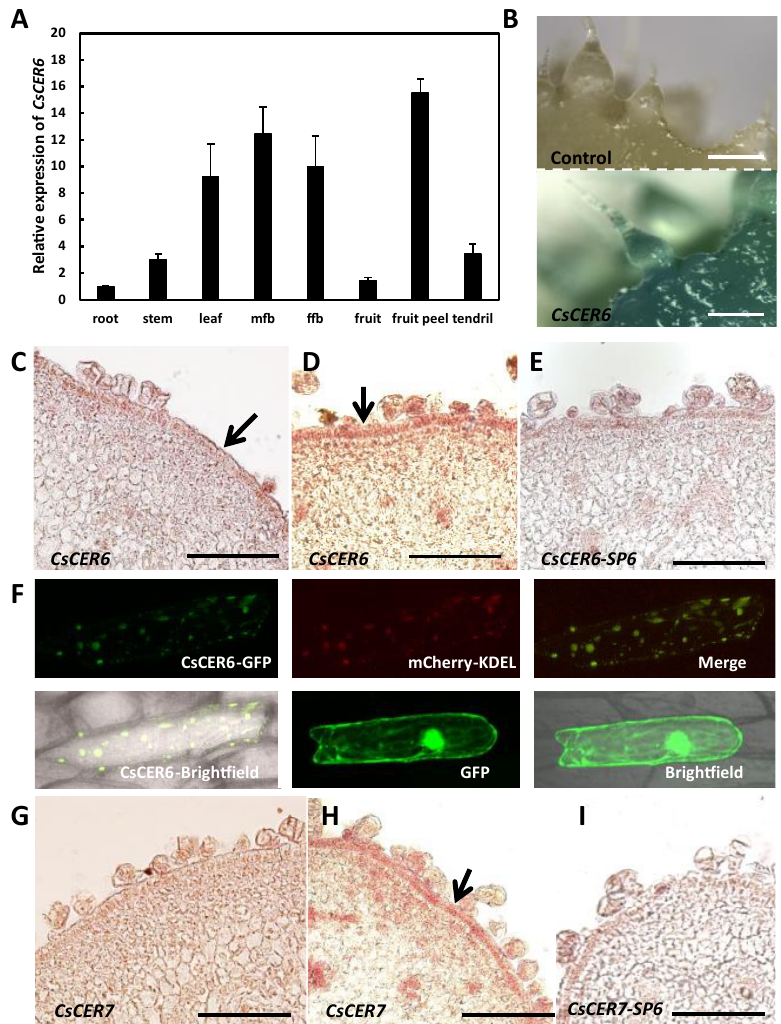
Figure 3. The expression pattern of CsCER6 and CsCER7 . ( A ) qRT-PCR analysis of CsCER6 in various tissues in cucumber. The data of columns are the mean ± standard deviation. ( B ) Spatial expression pattern of CsCER6 detected by a GUS reporter gene assay in cucumber fruit. ( C – E ) In situ hybridization of CsCER6 ( C , D ) and CsCER6 -sense probe ( E ) in 3461 fruits. ( C ) The fruit before anthesis; ( D ) the fruit at anthesis. ( F ) Subcellular localization of CsCER6 protein in onion epidermal cells. ( G – I ) In situ hybridization of CsCER7 ( G , H ) and CsCER7 -sense probe ( I ) in 3461 fruits. ( G ), the fruit before anthesis; ( H ), the fruit at anthesis. mfb, male flower buds; ffb, female flower buds; mCherry-KDEL, ER (endoplasmic reticulum) marker with mCherry fluorescent protein. The arrows indicate epidermal cells in C – D and H . Scale bars = 1 mm in ( B ); 100 µm in ( C – E and G – I ).